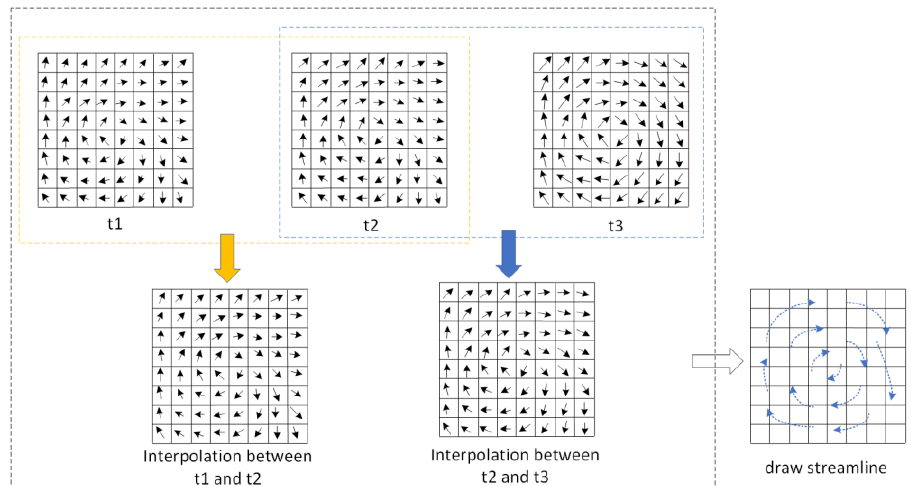
Figure 2. Schematic of wind field interpolation.